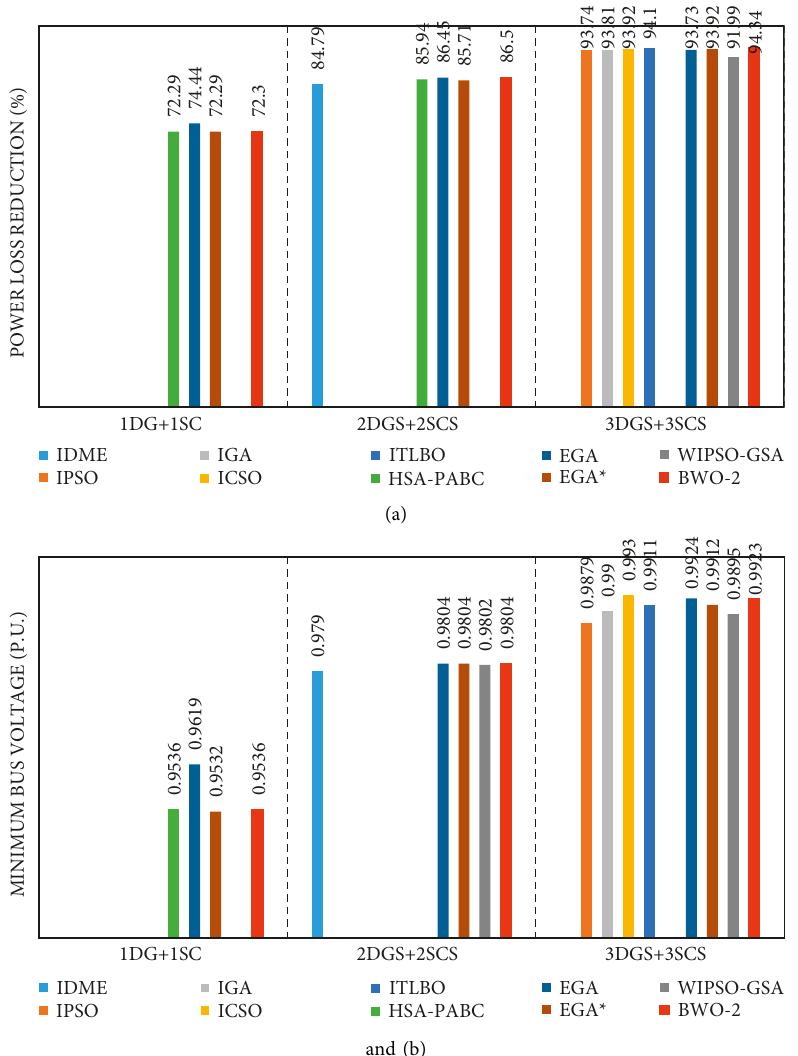
Figure 13: Performance comparison of BWO-2 against the improved variants of optimization algorithms for (a) power loss reduction and (b) minimum bus